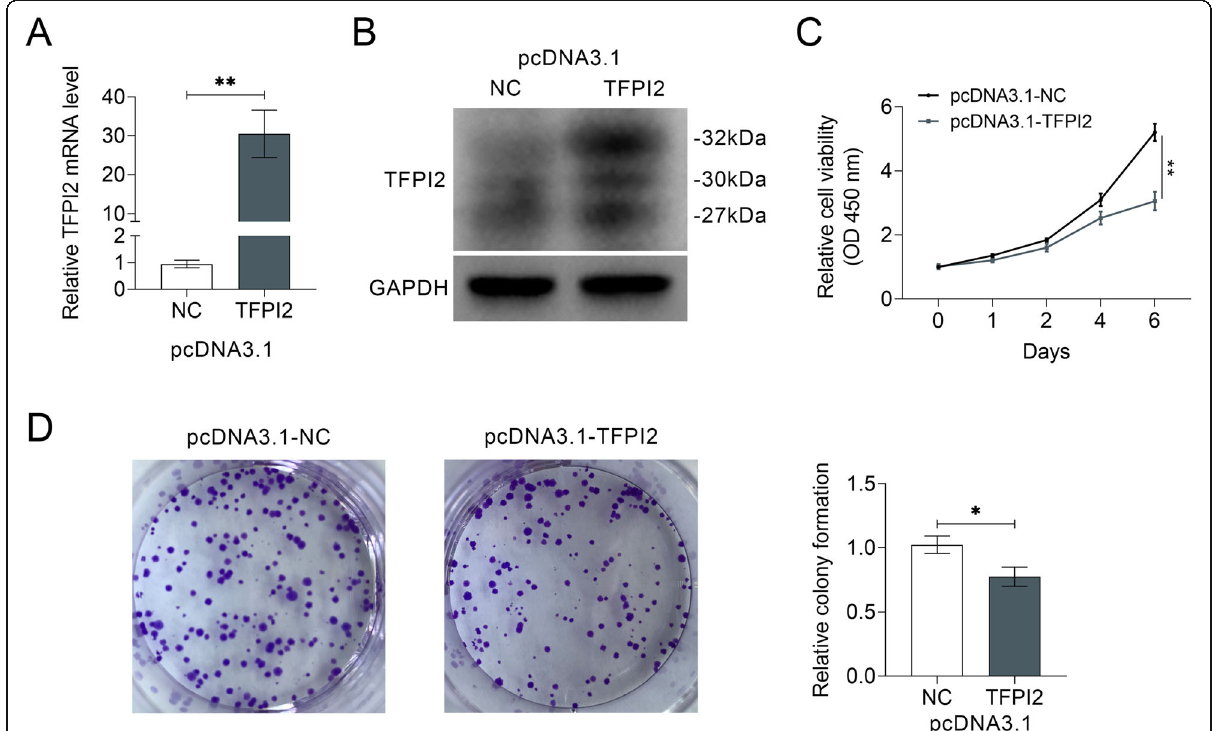
Fig. 2 Over-expression of TFPI2 suppressed cell viability and proliferation of breast cancer. a Up-regulation of TFPI2 in MDA-MB-453 cells transfected with pcDNA 3.1-TFPI2 indicated by qRT-PCR. ** represents pcDNA 3.1-TFPI2 (TFPI2) vs. pcDNA 3.1-NC (NC), p < 0.01. b Up-regulation of TFPI2 in MDA-MB-453 cells transfected with pcDNA 3.1-TFPI2 detected by western blot. c Over-expression of TFPI2 inhibited cell viability of MDA- MB-453 cells. ** represents pcDNA 3.1-TFPI2 vs. pcDNA 3.1-NC, p < 0.01. d Over-expression of TFPI2 inhibited cell proliferation of MDA-MB-453 cells. * represents pcDNA 3.1-TFPI2 vs. pcDNA 3.1-NC, p <